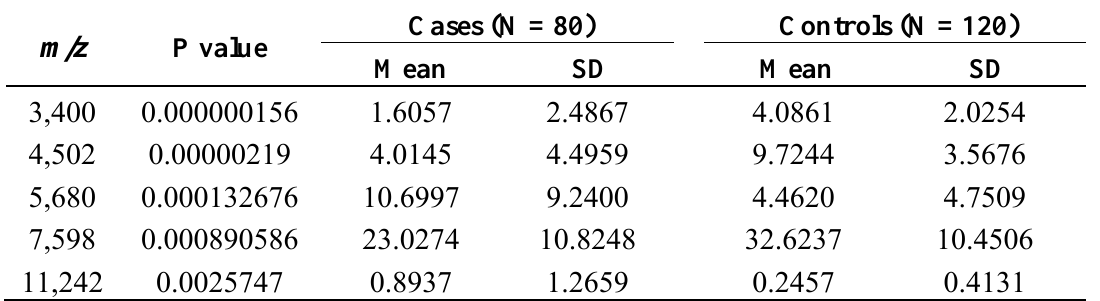
Table 3. Significant differential protein peaks used to construct the decision tree